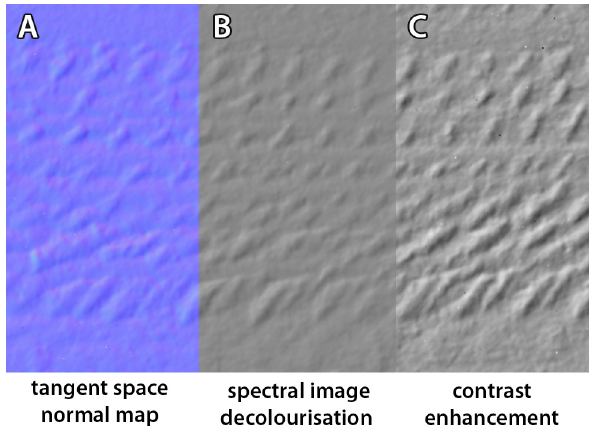
Figure 8. Encoding the object’s shape and structural details (C) by enhancing the contrast of the decolourised (B) tangent space normal map (A).